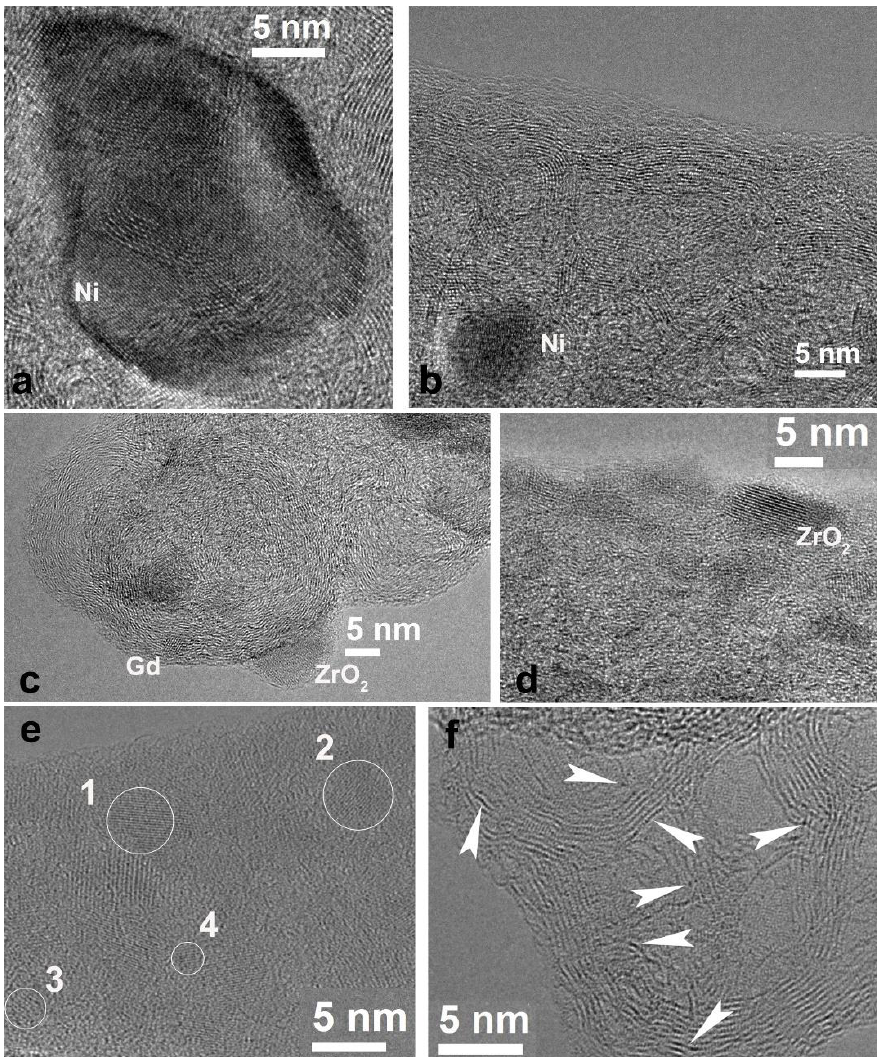
Figure 2. HRTEM images of pyrolyzed CNF / Zr / Ni / Gd composite 1: ( a ) Ni particle of a large size; ( b ) Ni particle of a small size; ( c ) metal particles, grown on a surface of the onion-like carbon black particles; ( d ) ZrO 2 particle on the surface of a CNF; ( e ) metal nanoparticles in a thin carbon layer (1–3: Gd / Gd 2 O 3 and 4: ZrO 2 ); ( f ) atomic clusters, atom chains, and isolated atoms of metal (shown by white arrows).